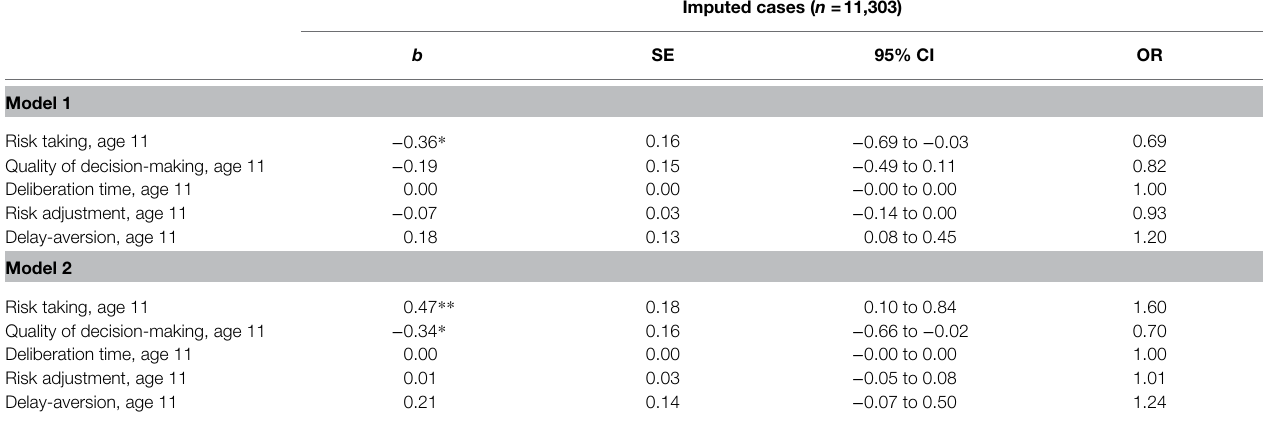
TABLE 5 | Predictive models of prodromal eating pathology.